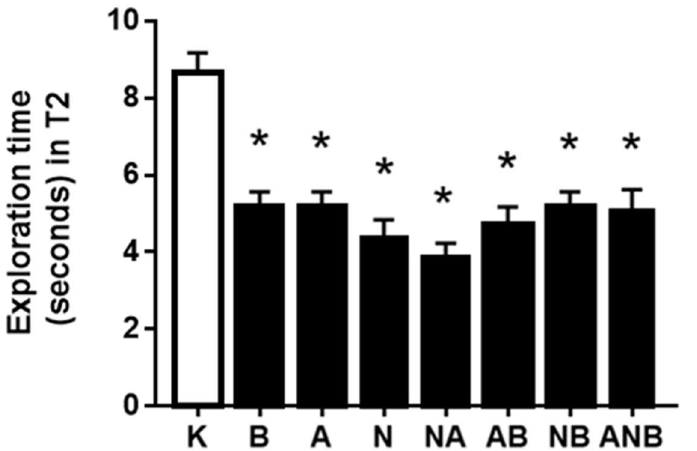
Figure 2. Exploration time expressed by different groups of rats during T2. The exploration time (s) in the novel object recognition test for ketamine-induced disorder in T2, mean values, and 95 percent confidence intervals are presented. The application protocol was injected ip immediately after T1. 1h ITI was used. In ketamine rats (3 mg/kg ip), medication (mg/kg ip) was: L-NAME (5) (N), L-arginine (100) (A), BPC 157 (0.01) (B), alone and/or together (L-NAME+L-arginine (NA), L- arginine+BPC 157 (AB), L-NAME+BPC 157 (NB), L-arginine+L-NAME+BPC 157 (ANB)), and saline 5 mL/kg ip (control ketamine) (K). The application was immediately before ketamine (L-NAME, L- arginine, and combination) or the application was immediately after ketamine (BPC 157 and com- binations). Dunnett’s multiple comparison test was used to compare control group (K) with treated groups. * p < 0.05 relative to ketamine. 3.2. Social Interaction Test Using the ketamine (8 mg/kg ip) 3 days’ protocol, social withdrawal assessment ap- peared as “L-NAME responsive, L-arginine non-responsive”. There were common ther- apy effects, namely antagonization (BPC 157), and antagonization (L-NAME). L-arginine was with opposite (worsening) effect. There was a shared inability of the L-NAME and L- arginine to antagonize each other effect, which may suggest the additional non-NO-sys- tem related mechanisms. BPC 157 counteraction potential completely disappeared with L-NAME and L-arginine and combination (Figure 3). Figure 3. Social interaction. The results for social interaction (s) in open field in the ketamine-in- duced social interaction test (SIT), mean values, and 95 percent confidence intervals are presented. In the ketamine rats (8 mg/kg ip/3 days), medication (mg/kg ip) was at the last ketamine challenge: L-NAME (5) (N), L-arginine (100) (A), BPC 157 (0.01) (B), alone and/or together (L-NAME+L-argi- nine (NA), L-arginine+BPC 157 (AB), L-NAME+BPC 157 (NB), L-arginine+L-NAME+BPC 157 (ANB)), and saline 5 mL/kg ip (control ketamine) (K). The application was immediately before